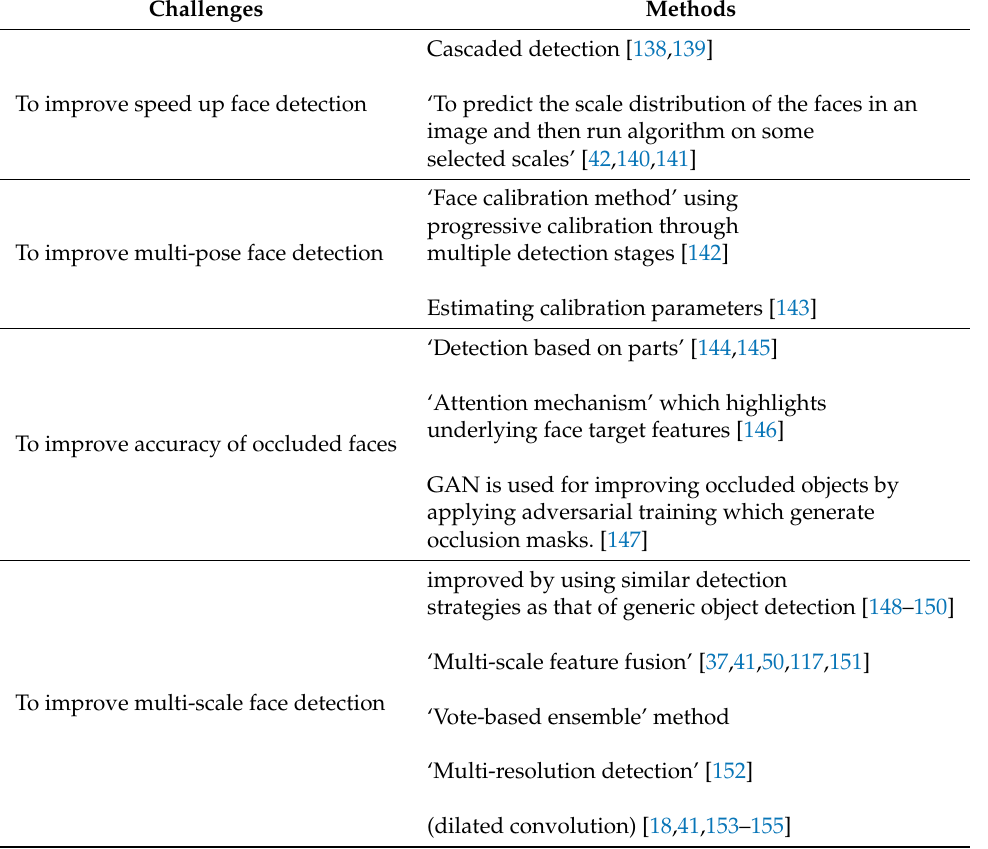
Table 10. Remedies to improve challenges arising in face